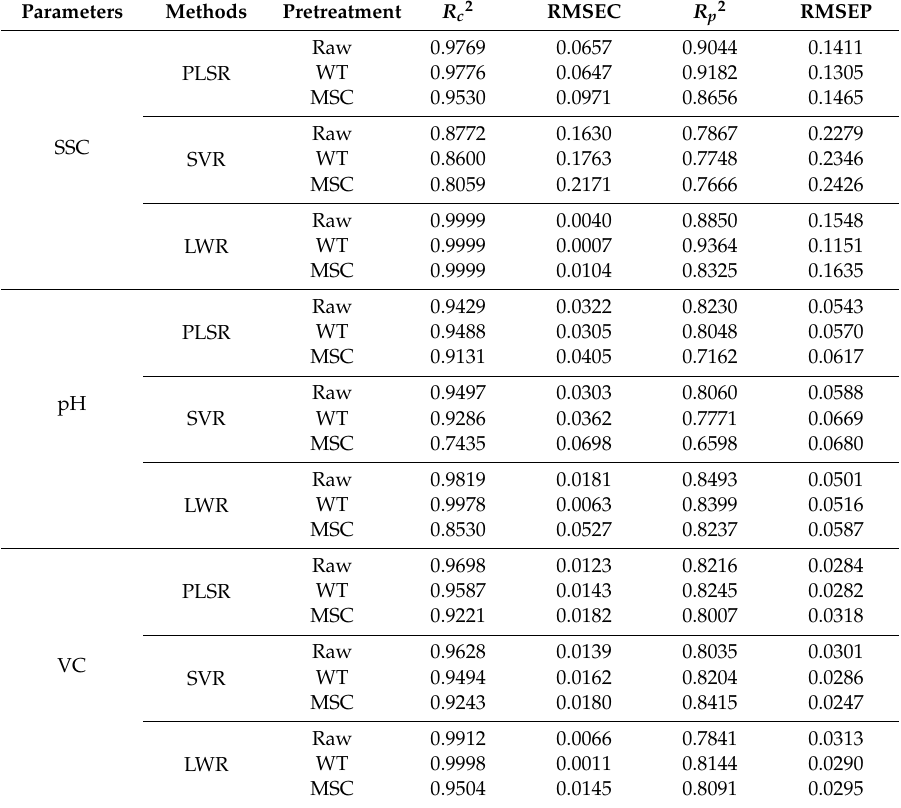
Table 2. Prediction results of the SSC, pH, and VC of 120 strawberries by using spectroscopy. RMSEC = root mean square error of cross-validation; RMSEP = root mean square error of